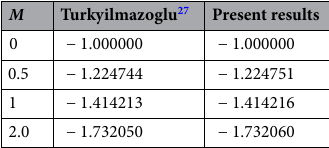
Table 1. Solution comparison for f ′′ ( 0 ) with Turkyilmazoglu 27 when We